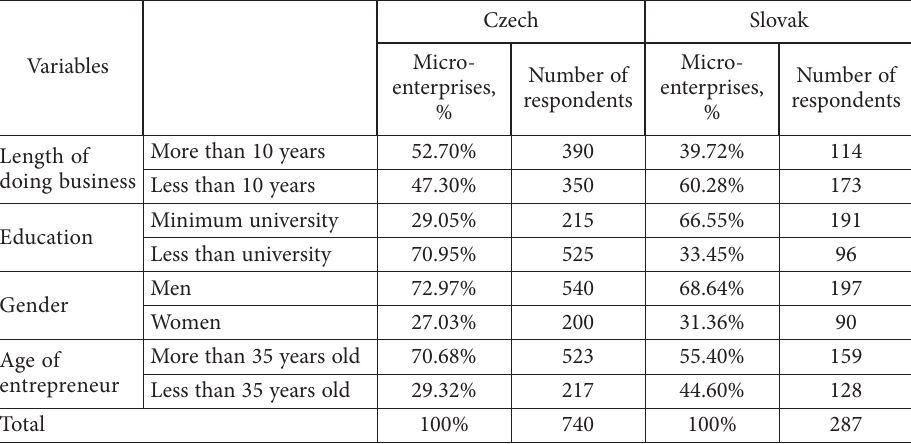
Table 1. The structure of the selected samples (source: own processing)